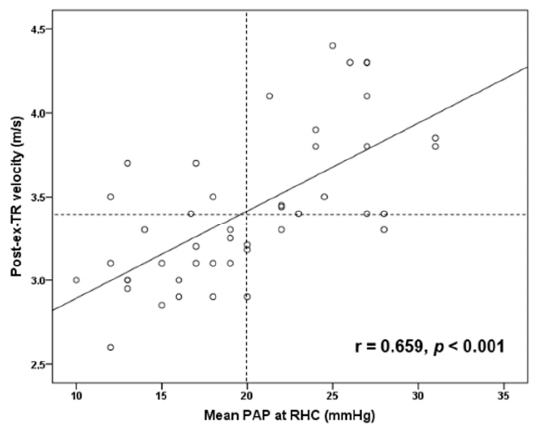
Figure 2. Scatter plot correlation of post-exercise tricuspid regurgitation velocity (post-ex-TR velocity) with resting mean pulmonary arterial pressure (PAP) at right-heart catheterization (RHC). Vertical dashed line indicates mean PAP of 20 mmHg, while horizontal dashed line indicates post-ex-TR velocity of 3.4 m/s.